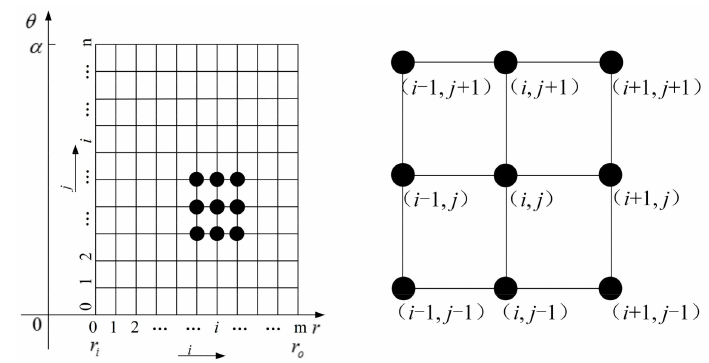
Figure 5. Solution domain discretization of finite difference algorithm (The black circles are adjacent discrete